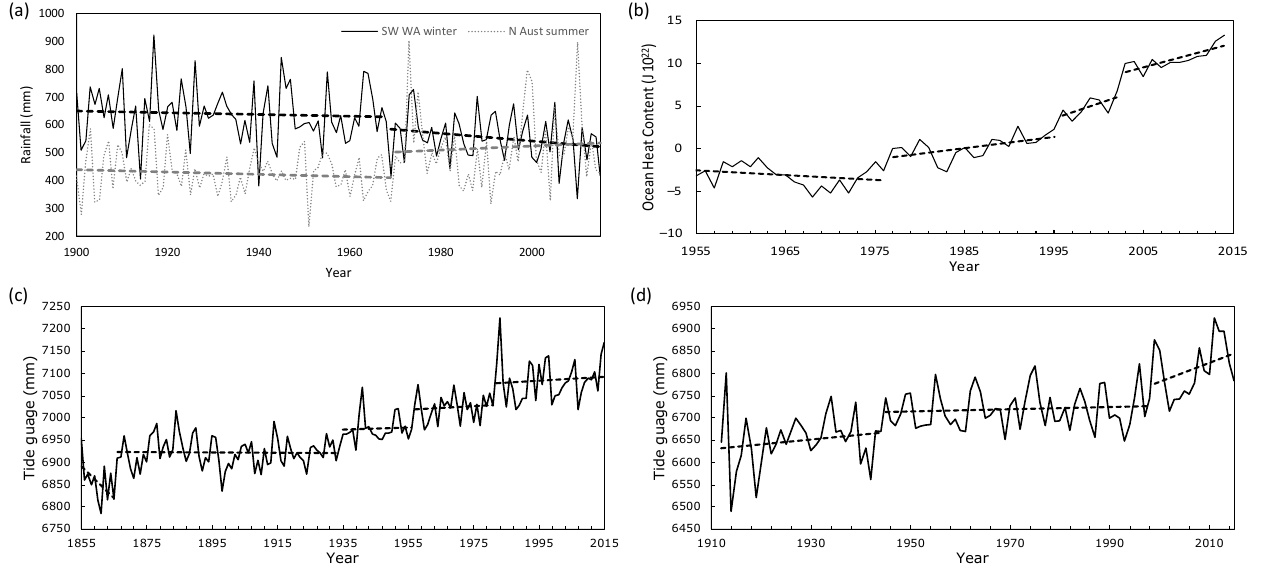
Figure 6. Records showing internal trends separated by step changes of (a) total rainfall for south-west Western Australia (winter) and northern Australia (summer, 1900–2015); (b) global ocean heat content of the top 700m (1955–2014); (c) tide gauge data for San